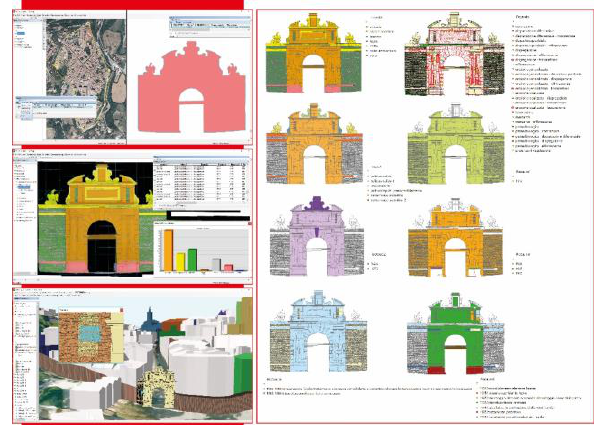
Figure 2. 3D reconstruction of the various building phases